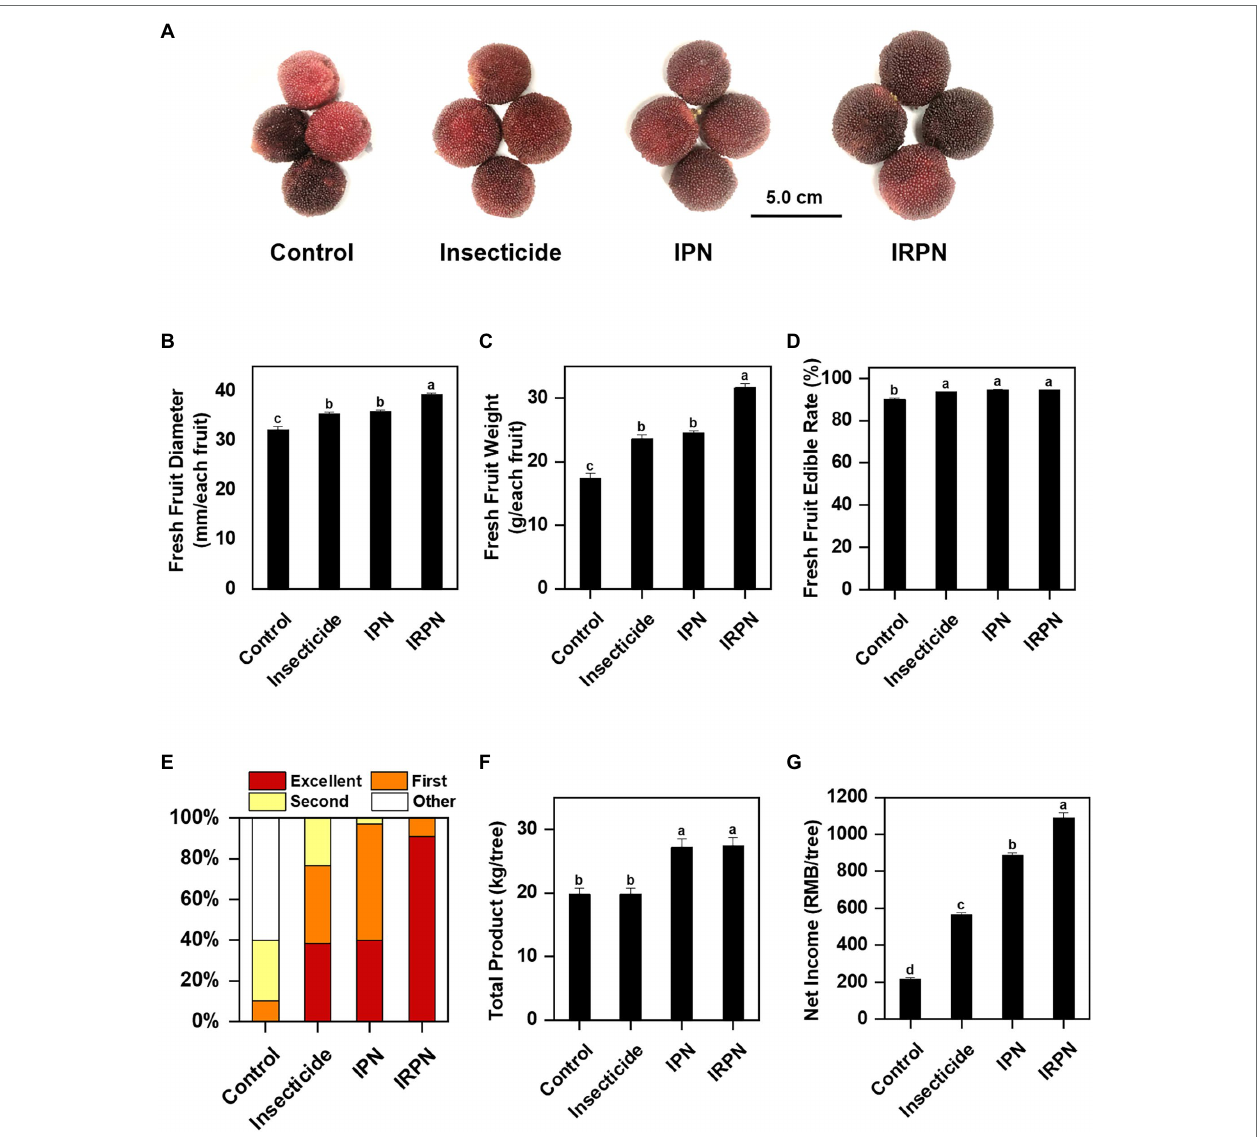
FIGURE 2 | Fruit yields of Chinese bayberries grown under different planting conditions. The trees were grown under natural conditions (controls) or treated separately with insecticides, IPNs or IRPNs. (A) Photos of fresh Chinese bayberries. (B–D) Fruit diameter (mm/each fruit) (B) , weight (g/each fruit) (C) and edible rate (%) (D) measured in a single Chinese bayberry. (E) Percentages of Chinese bayberry fruits of different grades according to commercial standards (special ≥ 25 g, 25 g > first ≥ 21 g, 21 g> second ≥ 18 g, 18 g>other). (F) Total fruit yield (kg/tree) of each Chinese bayberry tree. (G) Total net income (RMB/tree) from each Chinese bayberry